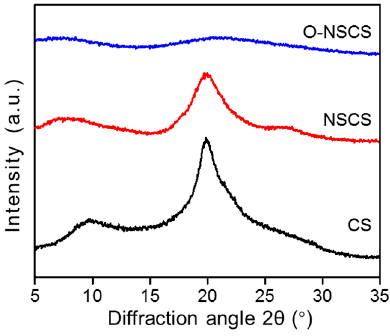
Figure 3. The X-ray diffraction patterns of CS, NSCS, and O-NSCS.